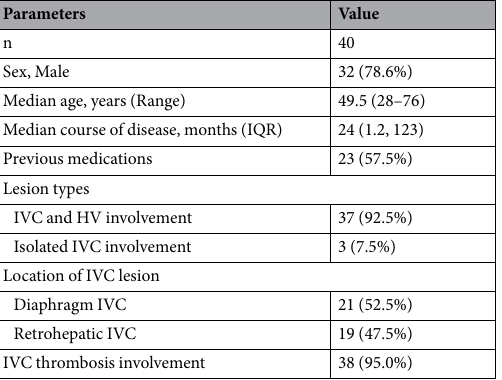
Table 1. Patient characteristics of study population. IVC, Inferior vena cava; HV, Hepatic vein.